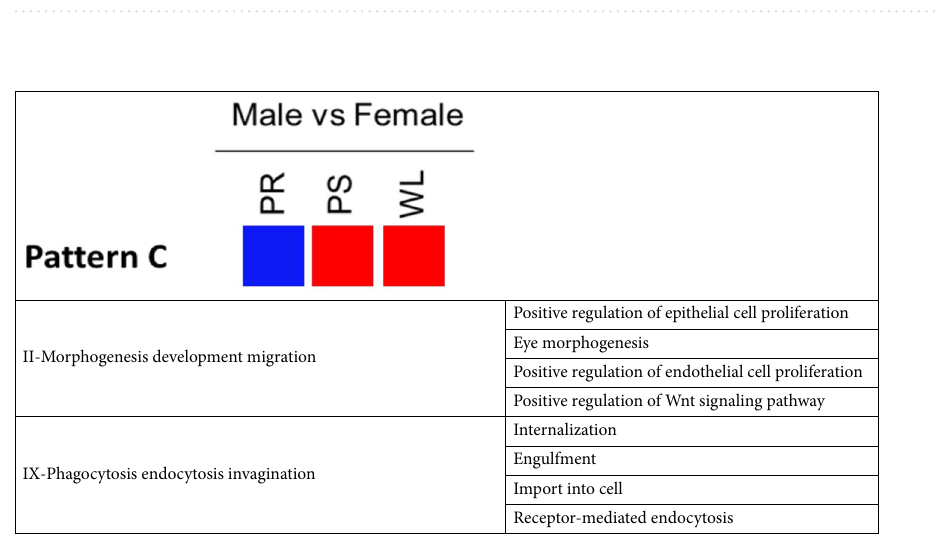
Table 7. Summary of clusters and gene sets included in the pattern D for the renal IRI sex comparison.